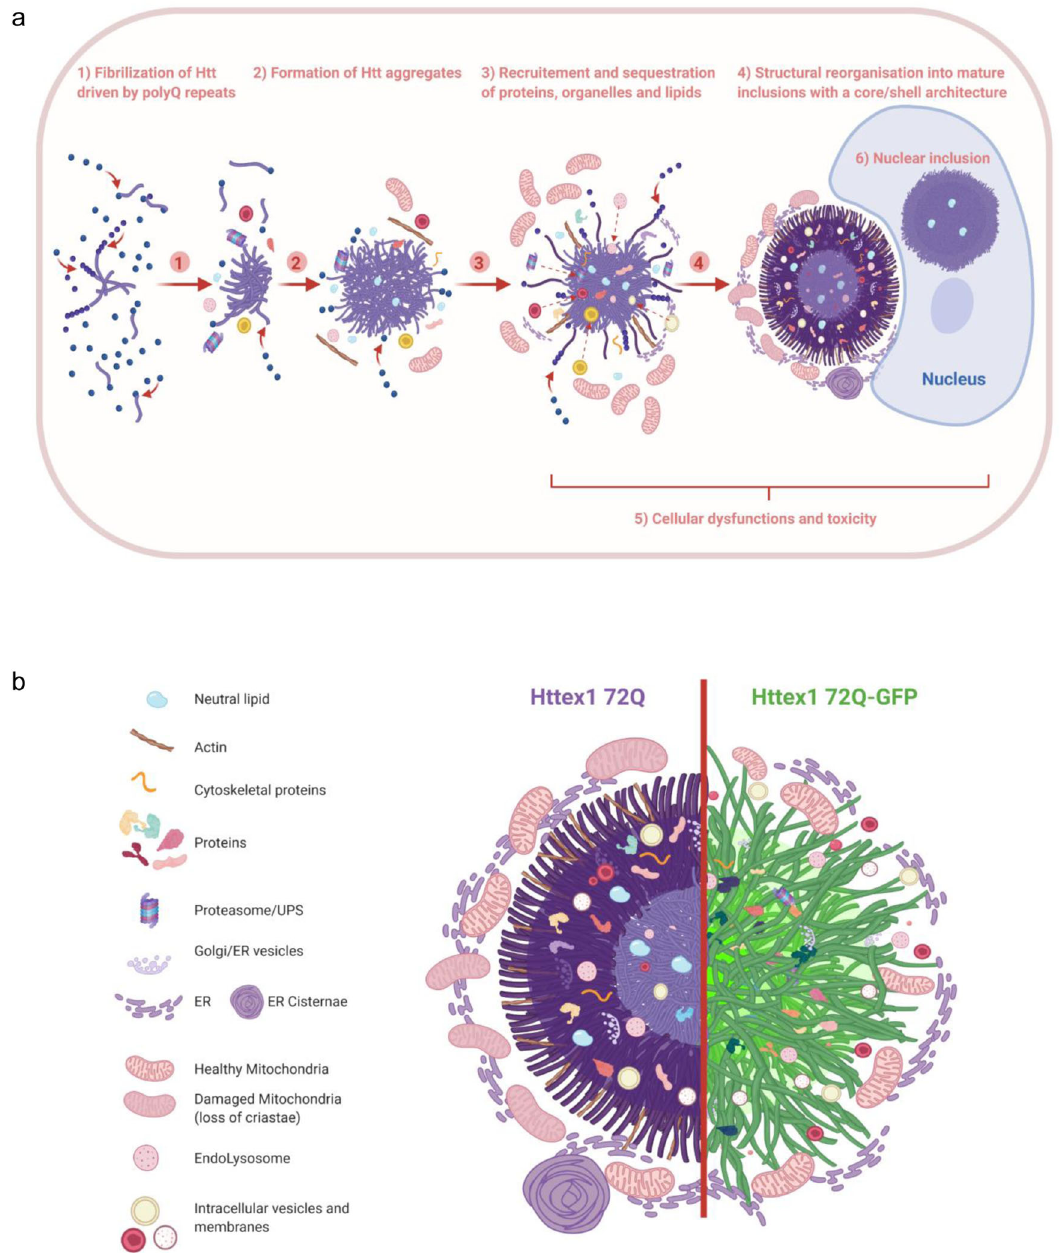
Fig. 10 The formation of Huntingtin inclusions is driven primarily by the polyQ repeat domain and involves the active recruitment and sequestration of lipids, proteins, and membranous organelles. a We separated the formation and organization of cytoplasmic Httex1 inclusions into different elements: (1) Even though the Nt17 domain can play a major role in early oligomerization steps, we showed that the fi brilization is driven by the polyQ repeats; (2) The initiation of inclusion formation was previously demonstrated to occur in a phase transition mechanism 14,31 and could involve fi rst the sequestration of proteins and organelles nearby either directly or indirectly; (3) During the growth of the inclusion, many cellular proteins, endomembranes, and lipids are recruited and sequestered inside the cytoplasmic inclusions; (4) Mature cytoplasmic Httex1 inclusions formed in cells display a core and shell structural organization if the polyQ length is relatively long (72Q) but not if it is close to the pathogenic threshold (39Q), even if inclusions are still formed in the second case. Cytoplasmic inclusion formation leads to the accumulation of mitochondria and ER network at the periphery; (5) Httex1 inclusion formation leads to the adaptation of the ER-mitochondrial network and respirational dysfunction, as well as signi fi cant toxicity after long-term incubation; (6) Nuclear inclusions do not display a distinct core/shell organization similar to the cytoplasmic inclusions, but they are still detected as a ring, as they are impervious for antibodies. Nuclear tag-free Httex1 inclusions are also enriched in neutral lipids. b The depiction shows the distinct structural organization and cellular impact of Httex1 72Q (left) compared to Httex1 72Q-GFP (right). The arrangement and packing of Httex1 fi brils are different depending on the presence of GFP as well as the interactions, recruitment, and perturbation with surrounding